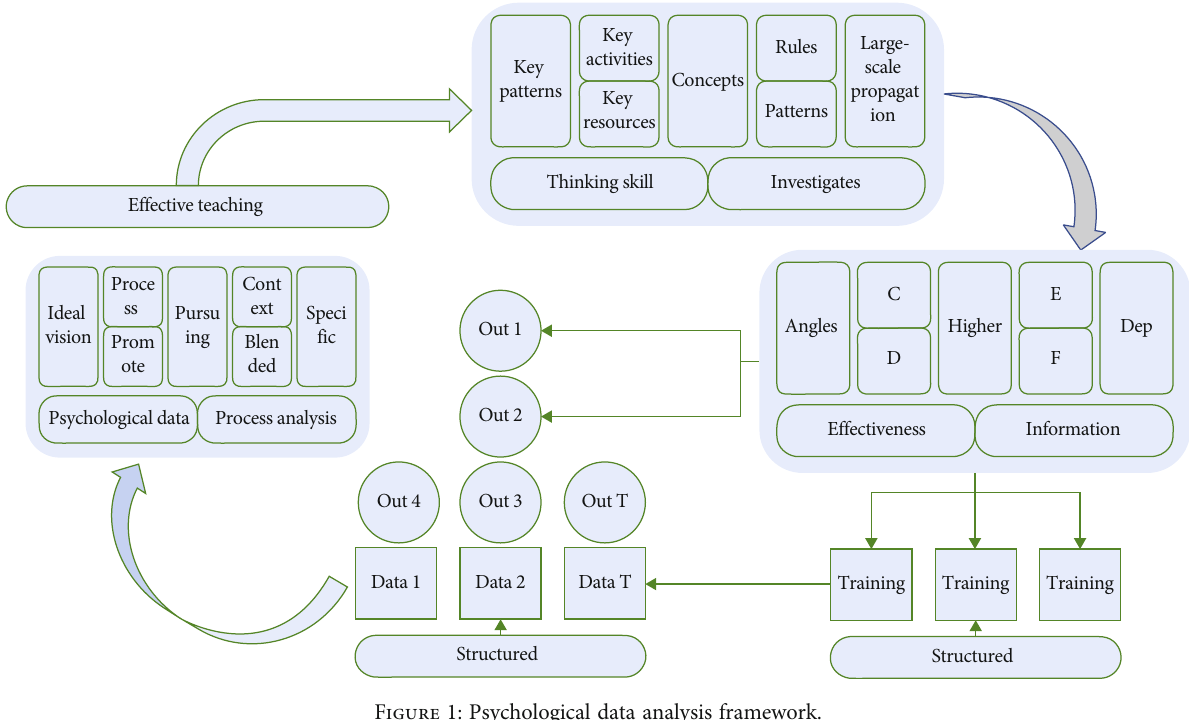
Figure 1: Psychological data analysis framework.